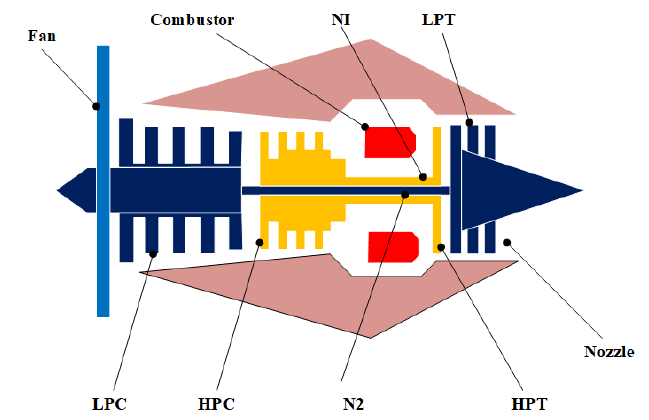
Figure 3. Inner structure of the turbofan employed in the Commercial Modular Aero-Propulsion System Simulation (C-MAPSS) data sets